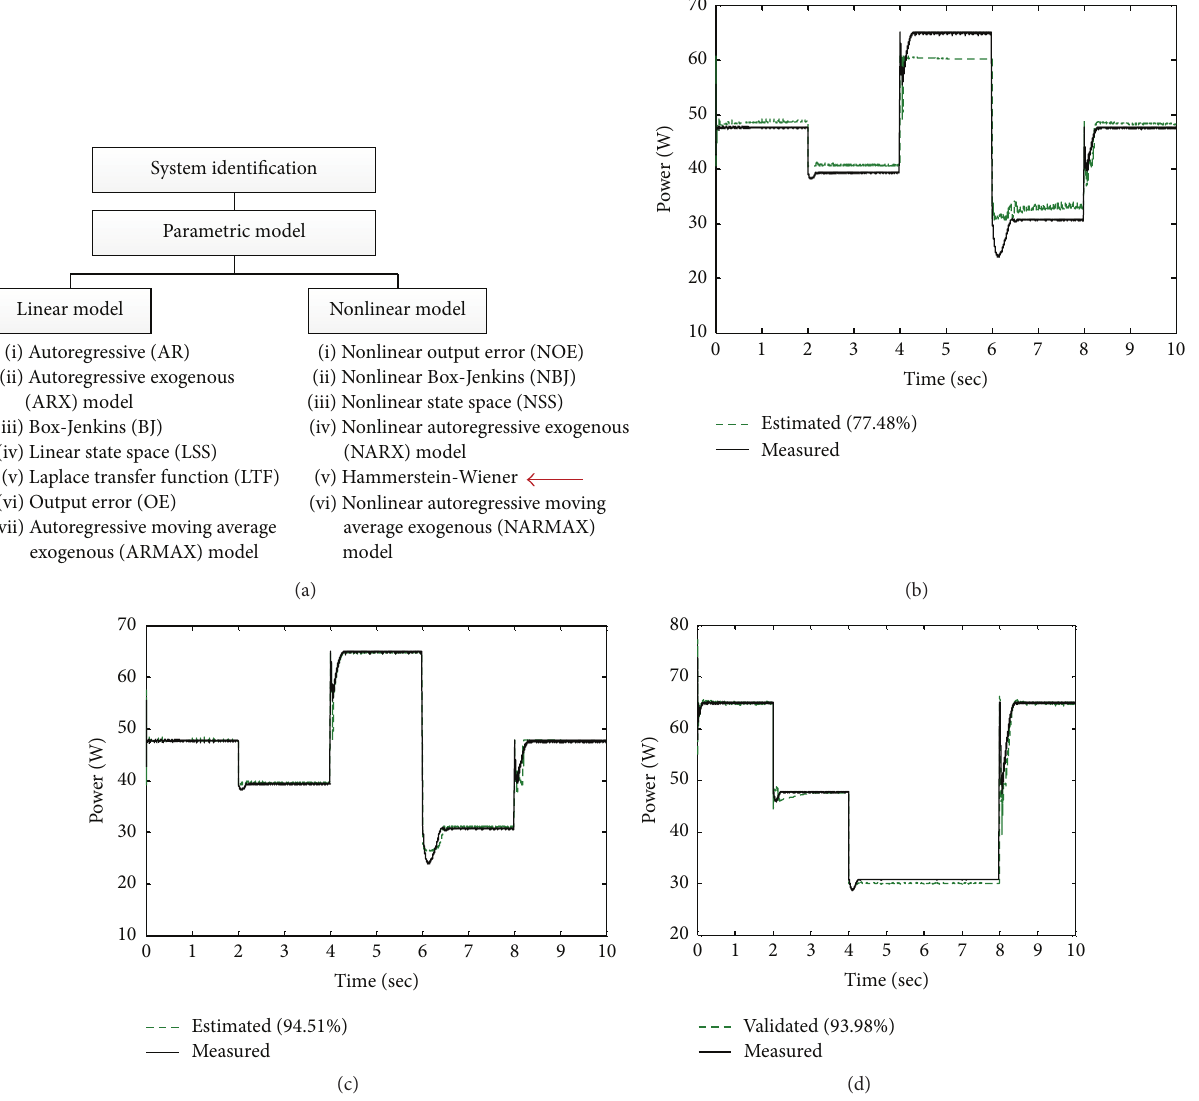
Figure 11: (a) System identification classifications. (b) Power output for the identified nonlinear ARX model with the estimation data set. (c) Power output for the identified Hammerstein-Wiener model with the estimation data set. (d) Power output for the identified Hammerstein- Wiener model with the validation data set.